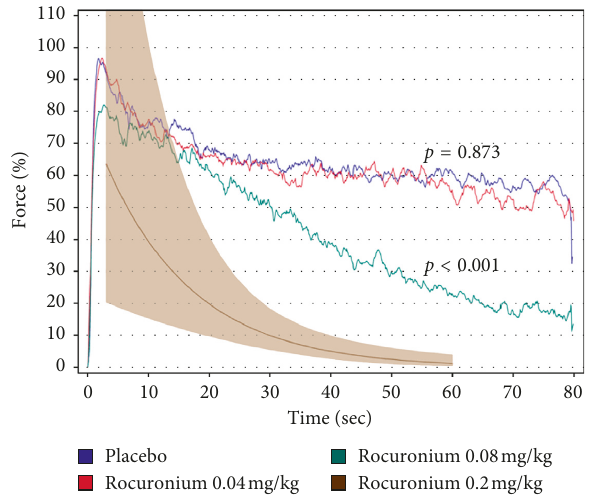
Figure 1: Average handgrip force over time from eight subjects after placebo, and rocuronium 0.04mg/kg and 0.08mg/kg was given. Subjects started to squeeze the dynamometer three minutes after placebo/rocuronium was given. A predicted curve between threeminutes and 60seconds with 95% confidence interval after a hypothetical dose of rocuronium 0.2 mg/kg is inserted. P values denote comparisons of average slope with placebo. The placebo curve does not reach 100% because subjects did not reach maxi- mum at the exact same time point (see text for details). Table 2: Effect of placebo and rocuronium 0.08mg/kg on twitch height (median